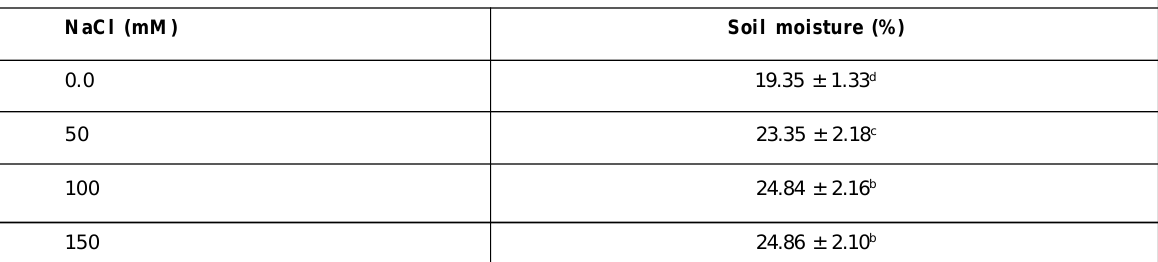
Table 3: Impact of different concentrations of NaCl on soil moisture in Phaseolus vulgaris L. NaCl